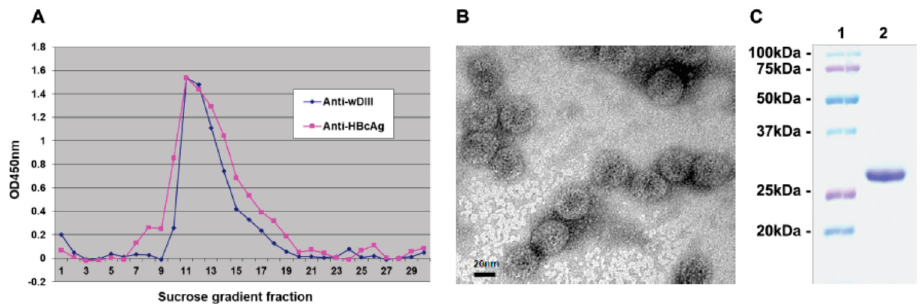
Figure 3. VLP assembly of plant-produced HBcAg-wDIII. Protein extract from HBcAg-wDIII-expressing leaves was subjected to a 10–60% sucrose gradient centrifugation. ( A ) ELISA of sucrose gradient fractions. An antibody against wDIII or HbcAg was used to detect the wDIII or HbcAg moiety in HBcAg-wDIII, respectively. ( B ) Electron microscopy of HBcAg-wDIII from peak fractions of the sucrose gradient. Bar = 20 nm. One representative field is shown. ( C ) SDS-PAGE analysis. Lane 1: molecular weight marker; lane 2: HBcAg-wDIII from peak fractions of the sucrose